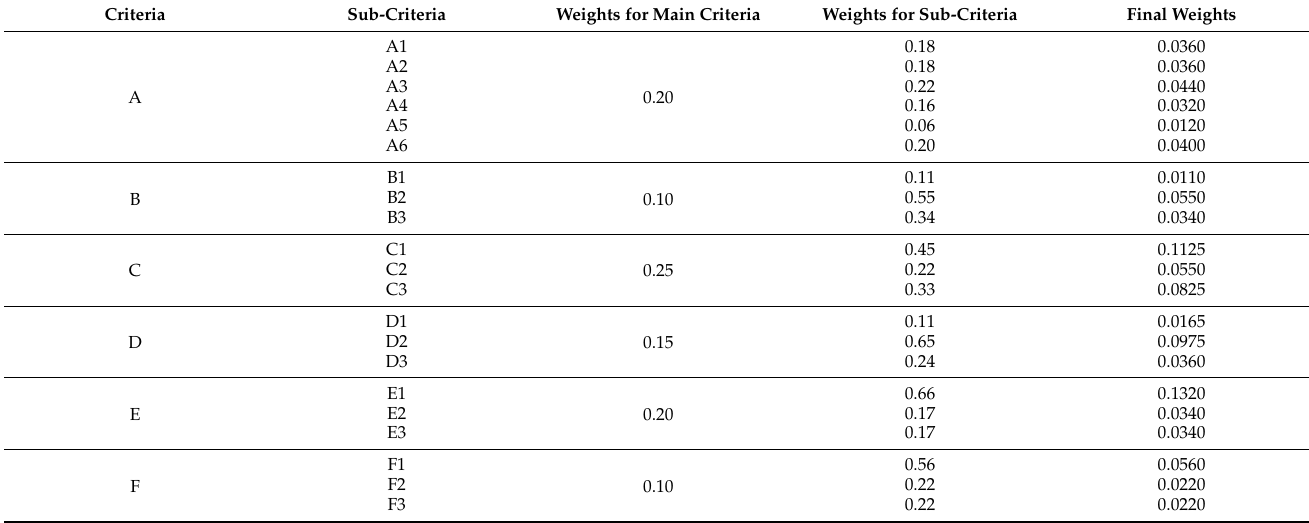
Table 5. List of weights values obtained for the main and